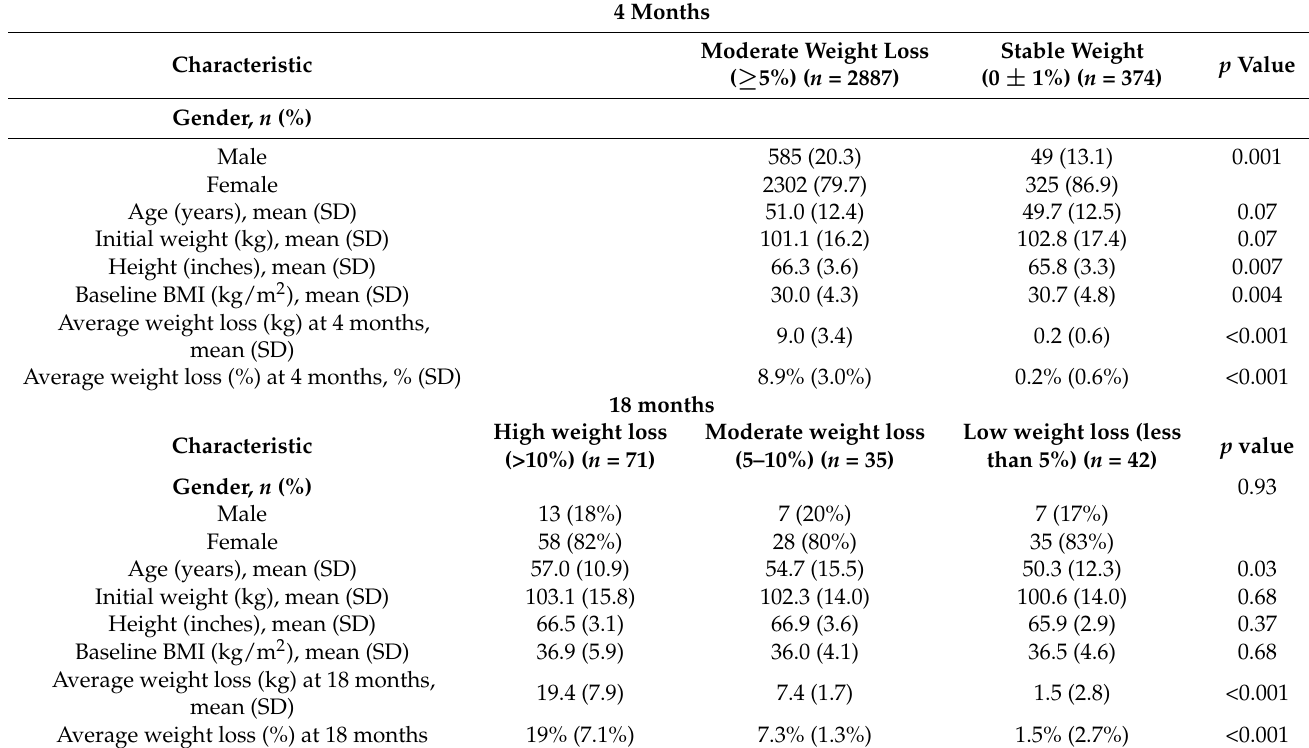
Table 1. Baseline characteristics of 4-month and 18-month participants. 4